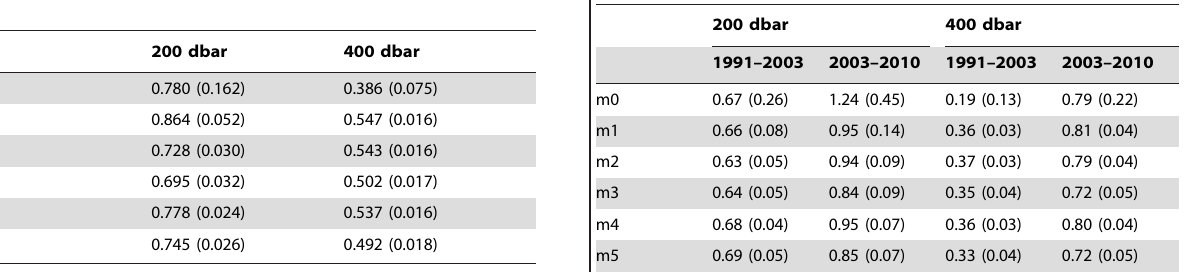
Adjustments for non-anthropogenic variability is based on data from all 5 surveys. Units are m mol/kg/yr. Standard errors are indicated in